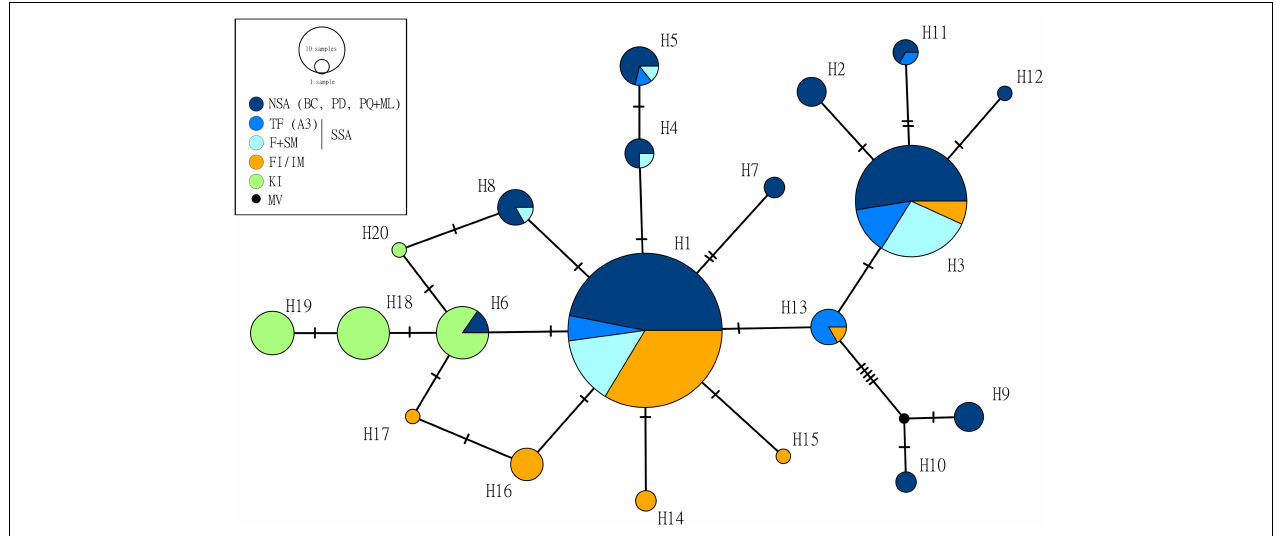
FIGURE 2 | Haplotype network of the 256 sequences. To focus on the greater distribution-wide patterns, localities were color-coded to broadly show their origin within the distribution of Commerson’s dolphins, as in the map: NSA (dark blue): Bahía Camarones (BC), Puerto Deseado (PD), and Punta Quilla and Monte León (PQ + ML); SSA ARG: Tierra del Fuego (A3, blue), and Fitzroy and Strait of Magellan (F + SM, light blue), Falkland Islands/Islas Malvinas (FI/IM, orange), and Kerguelen Islands (KI, green). MV, median vector. Transversal dashes indicate one mutational step. Haplotype frequencies are available in Table 1 .